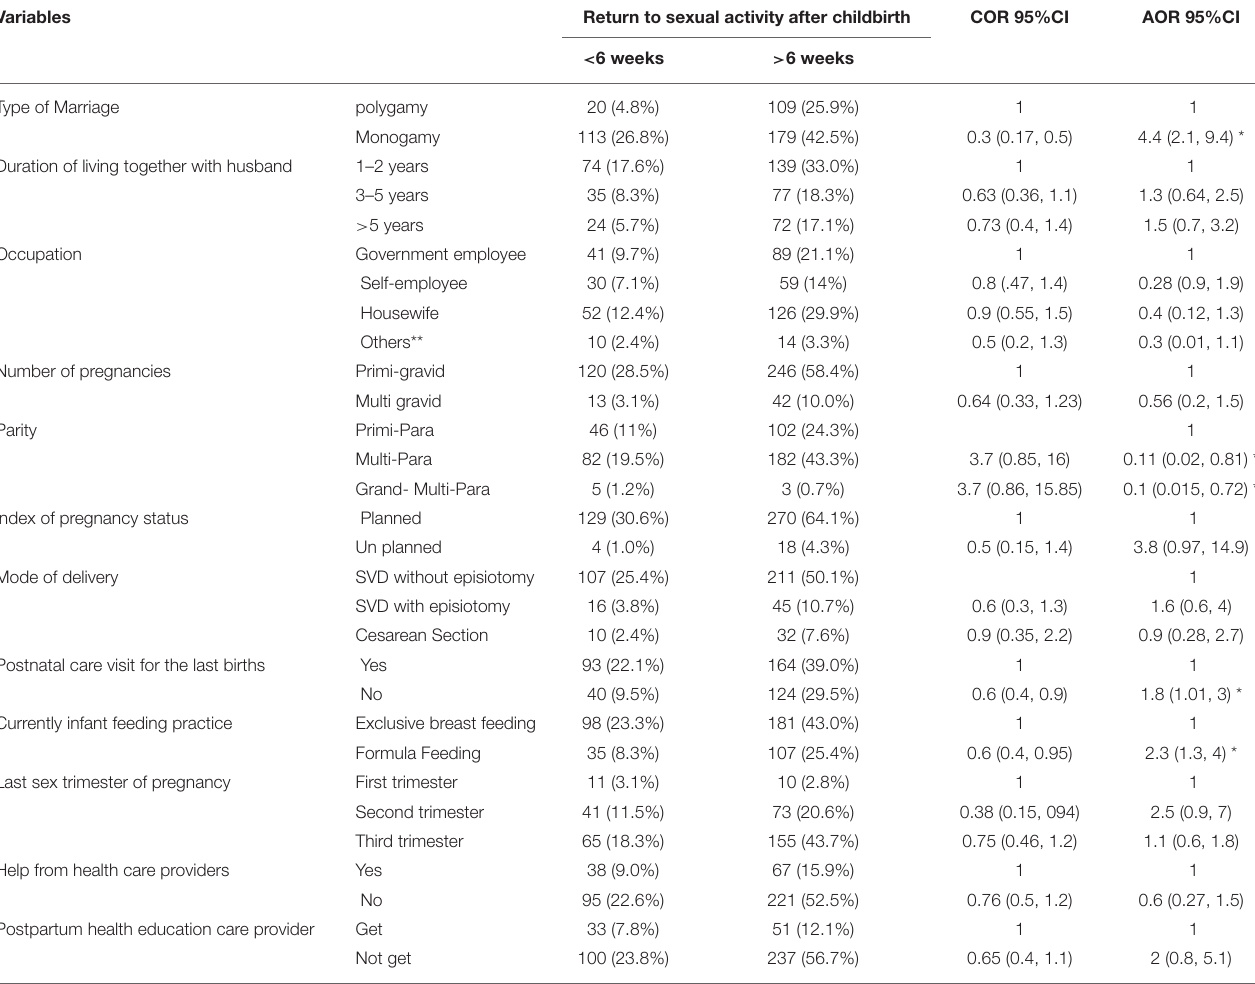
TABLE 5 | Factors associated with return to sexual activity within 6 weeks of childbirth among married post-partum women attending Salale University specialized and teaching hospital, from September to October 2021 ( n =